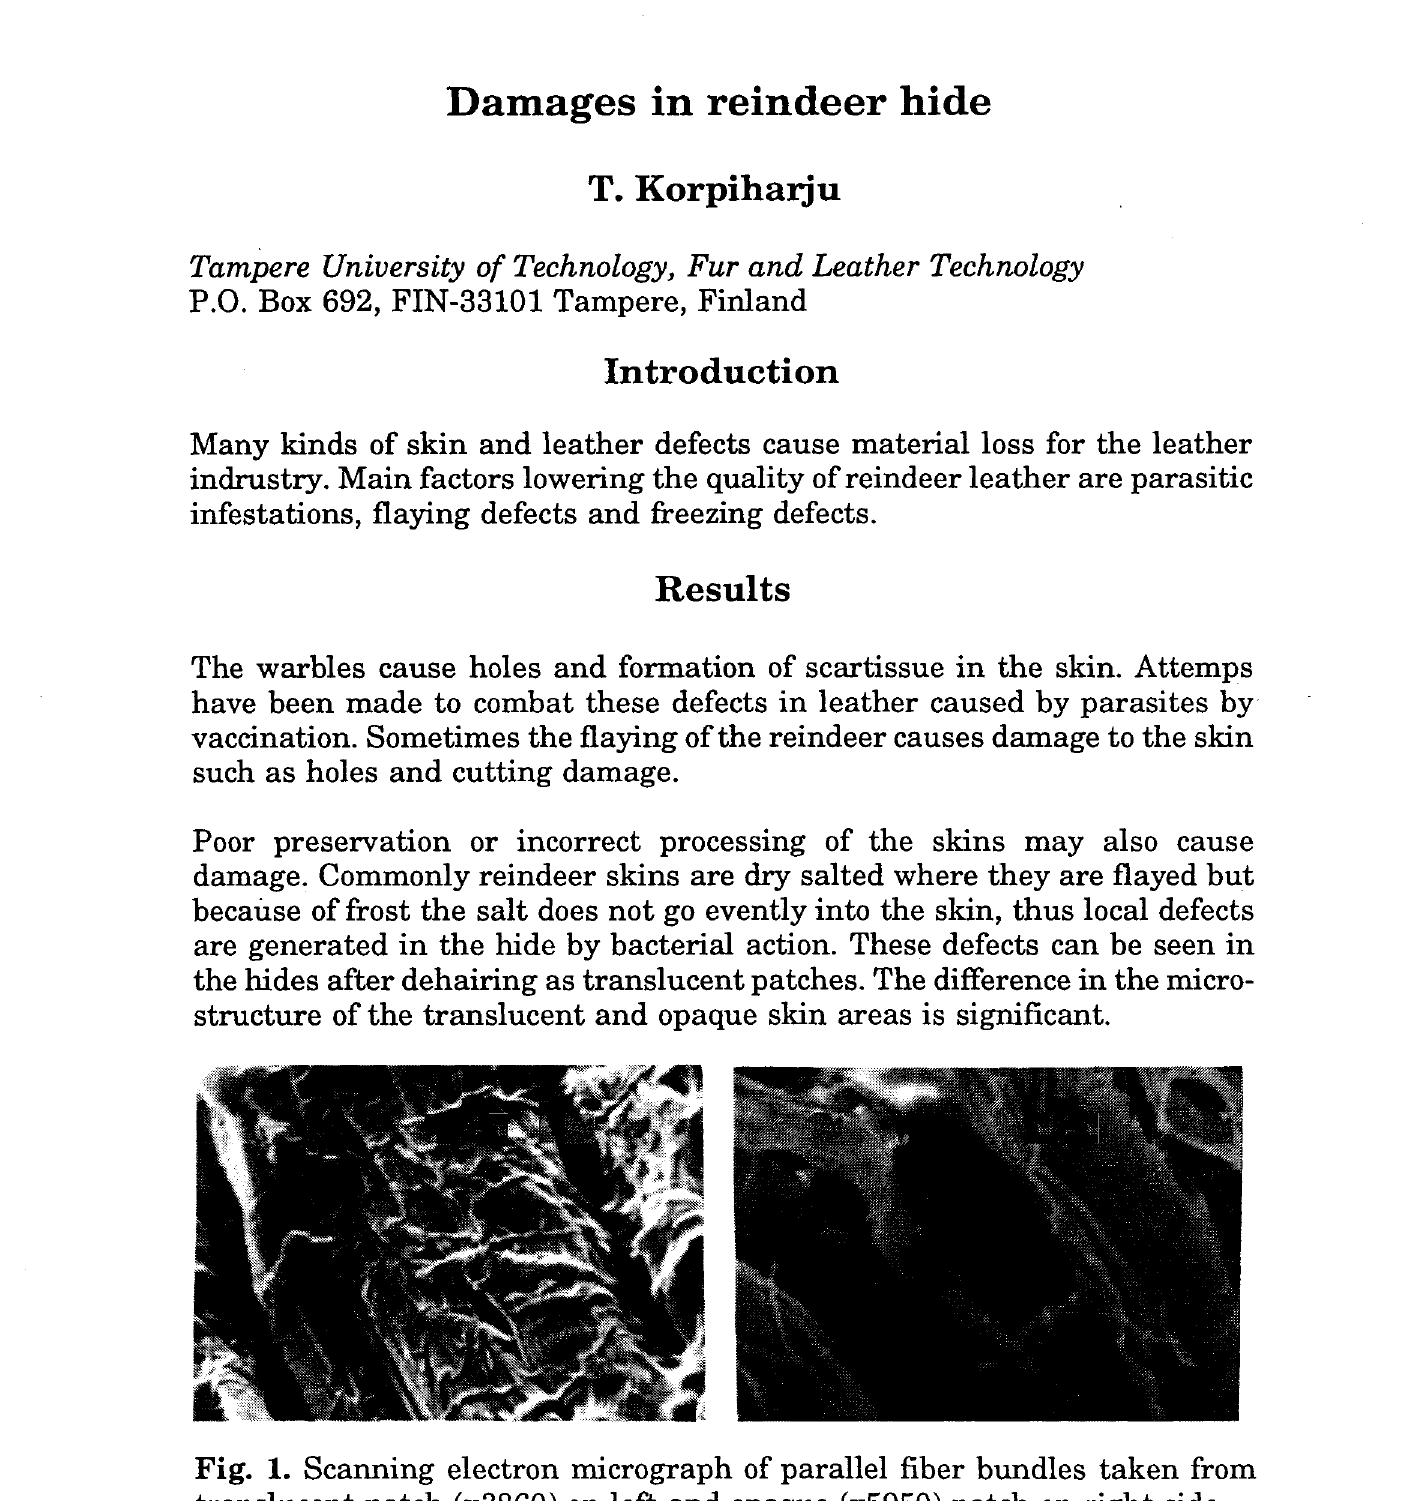
Fig. 1. Scanning electron micrograph of parallel fiber bundles taken from translucent patch (x3860) on left and opaque (x5950) patch on right